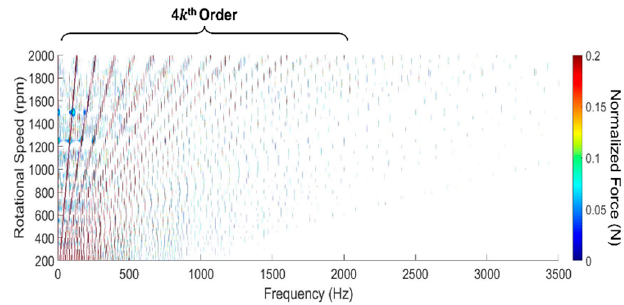
Figure 11. Waterfall graph of electromagnetic force.